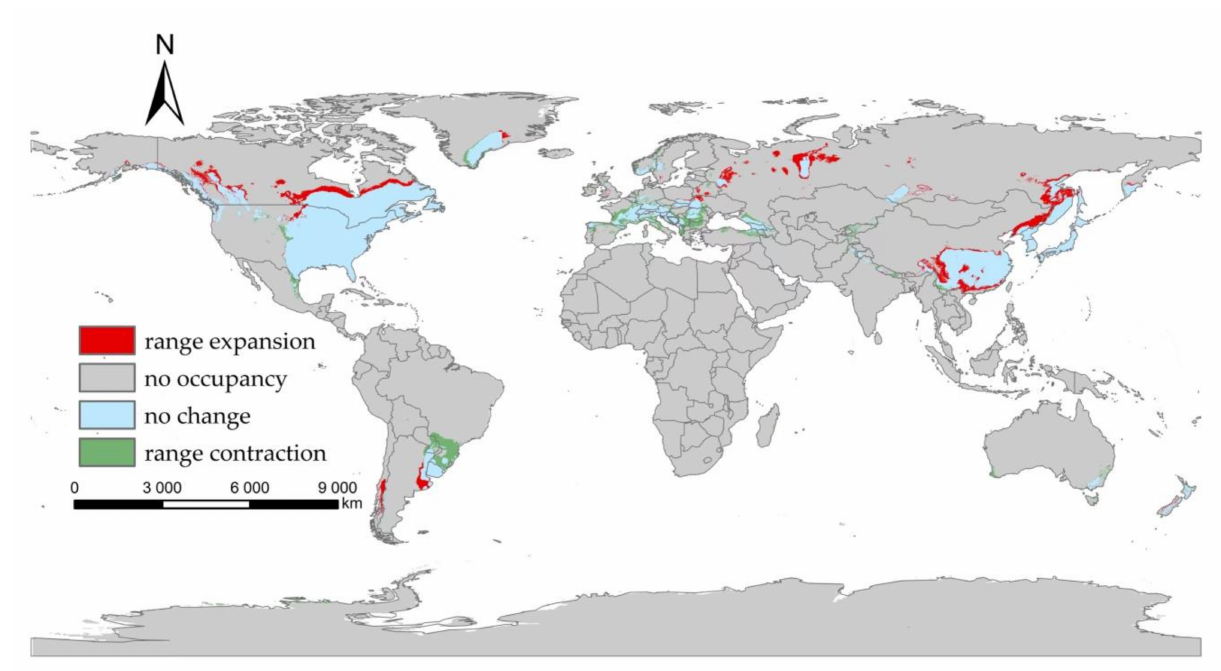
Figure 9. Comparison of the current suitable area with the period 2081–2100 under SSP5-8.5.